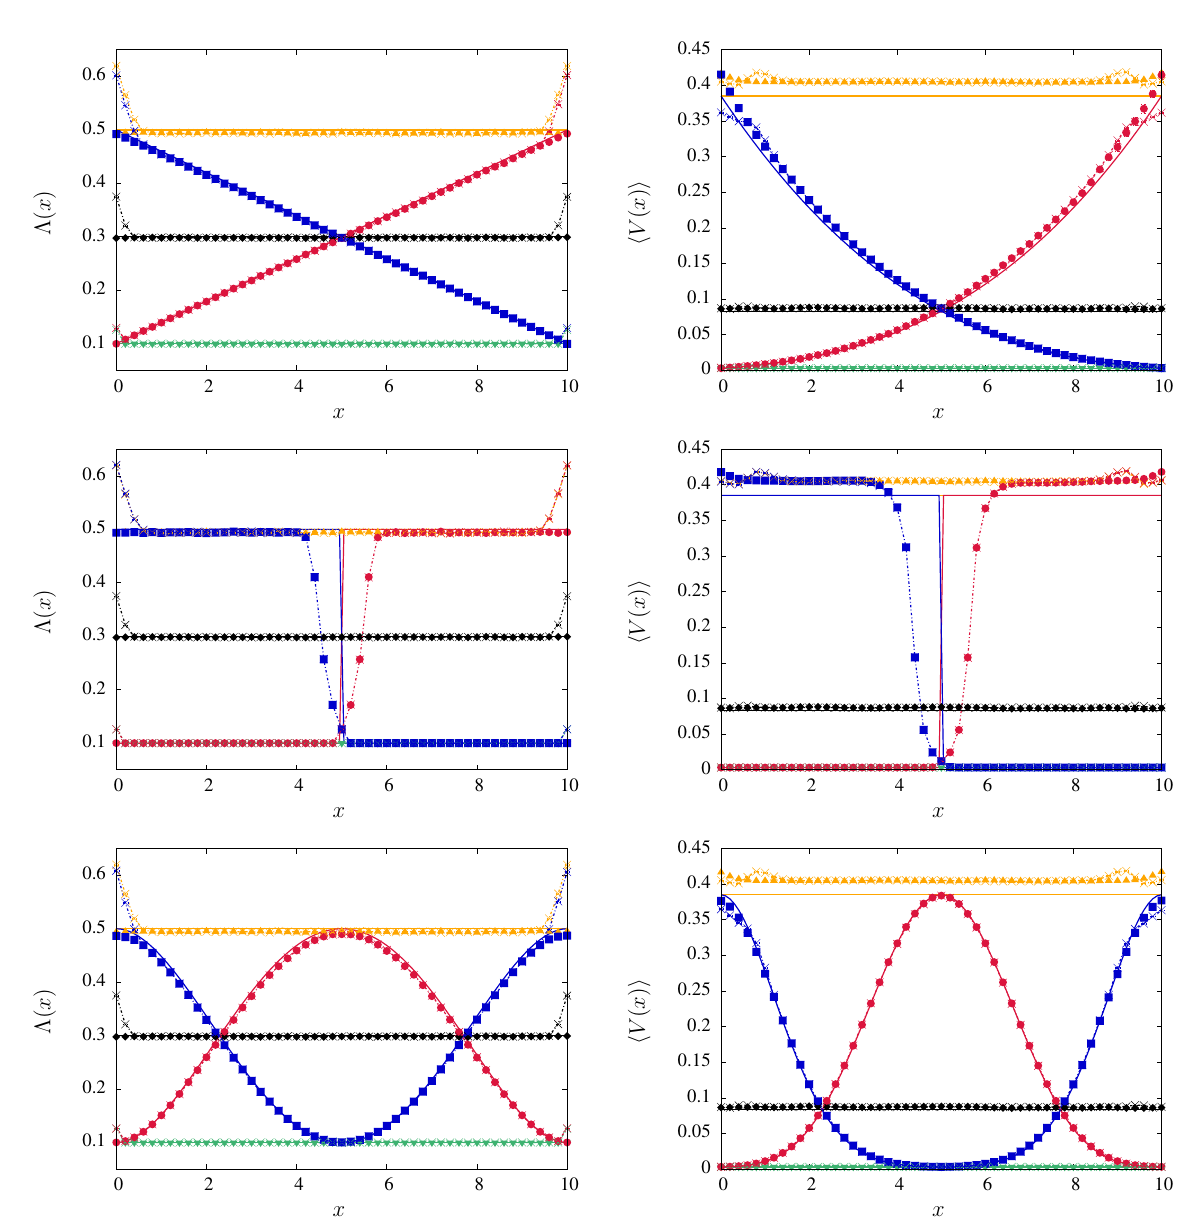
Figure 2: Average chord length Λ( x ) (left) and average volume (cid:104) V ( x ) (cid:105) (right) as a function of the spatial position x , in a box of size L = 10 , for different densities τ ( x ) . Solid lines to analytical formulas given by Eq. (2) , symbols correspond to results from Monte Carlo simulations: crosses (with a dotted line to guide the eye) represent the results obtained by = 0 and x = 10 ); the other symbols represent sampling the seed inside the box (i.e. x min max = − 1 and x = 11 ). the results obtained by extending the sampling of the seeds (i.e. x min max Green: law a; black: law b; orange: law c; red: law d (top), law f (center), law h (bottom); blue: law e (top), law g (center), law i